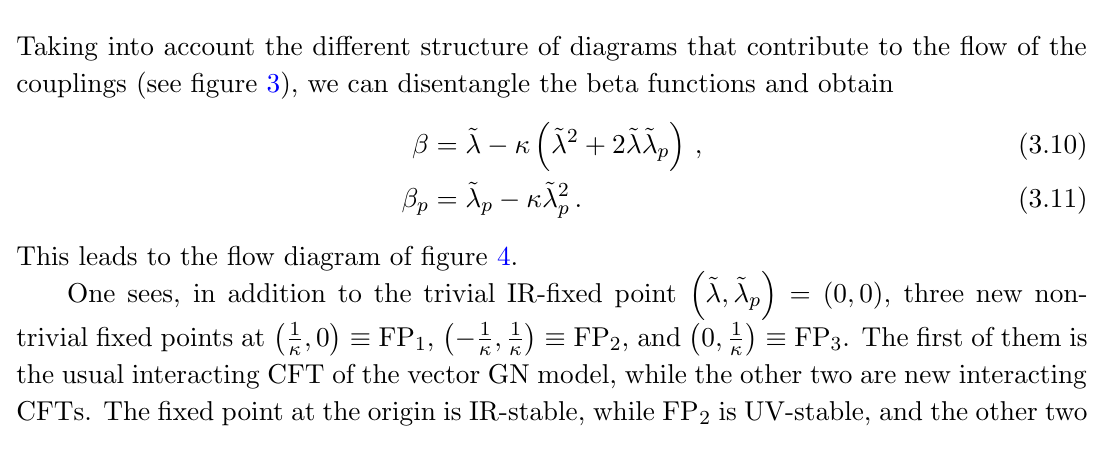
Figure 4 . Renormalization group (cid:13)ow in the dots denote the (cid:12)xed points, and red lines mark the zeros of either (cid:12) p or (cid:12) + (cid:12) p